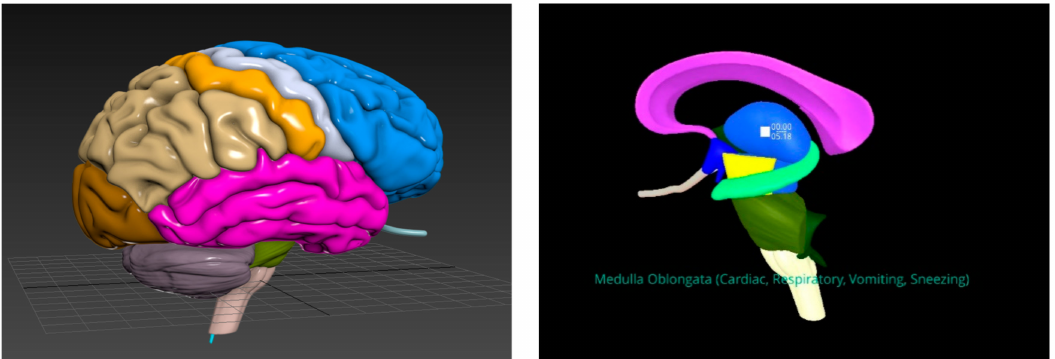
Figure 3. Example of the brain ( left ) and brainstem ( right ) utilised in the mobile learning study. The models have been colourised in specific ‘regions’ to assist student understanding of the concepts being described in the lesson. Sections of the model highlighted when the area was first being discussed in the background